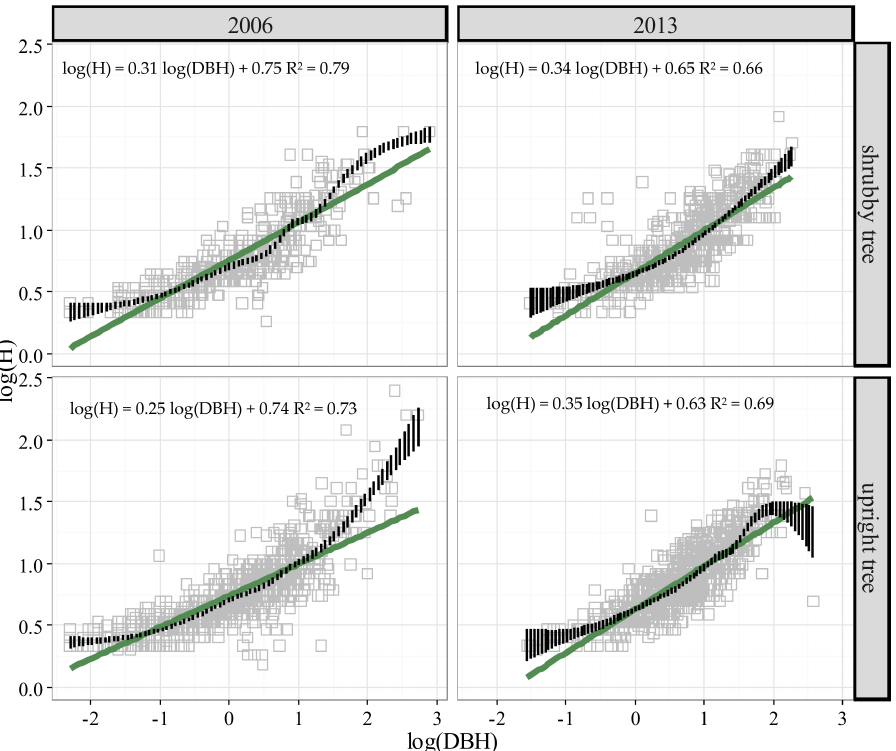
Figure 3. Stature change of upright and shrubby birch in the alpine treeline ecotone from 2006 to 2013. The value b of both shrubby (from 0.31 in 2006 to 0.34 in 2013) and upright birch (from 0.25 in 2006 to 0.35 in 2013) increased, indicating that tree stature of both growth forms became more tapered. Green lines represent results fitted by the linear model; dotted black curves are smoothing splines.